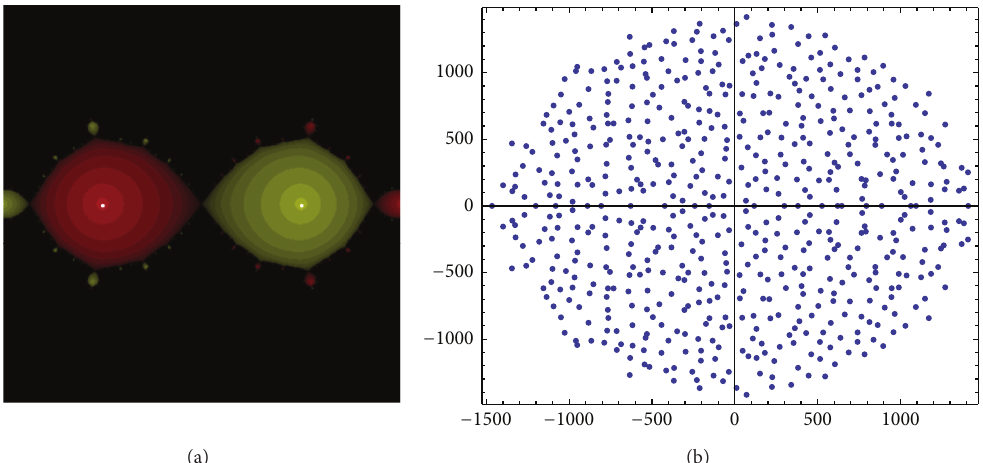
Figure 3: The basins of attraction for (37) and (a) for the complex polynomial 𝑥 2 − 1 = 0 (shaded by the number of iterations to obtain the solution) and the distribution of the eigenvalues of 𝐴[1] for Example 1.